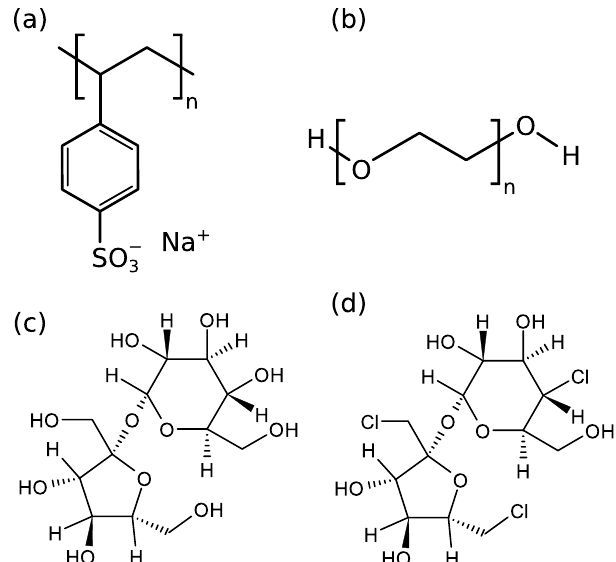
Figure 1. Chemical structures of ( a ) repeating unit of sodium polystyrene sulfonate (NaPSS), ( b ) re- peating unit of polyethylene glycol (PEG), ( c ) sucrose, and ( d )